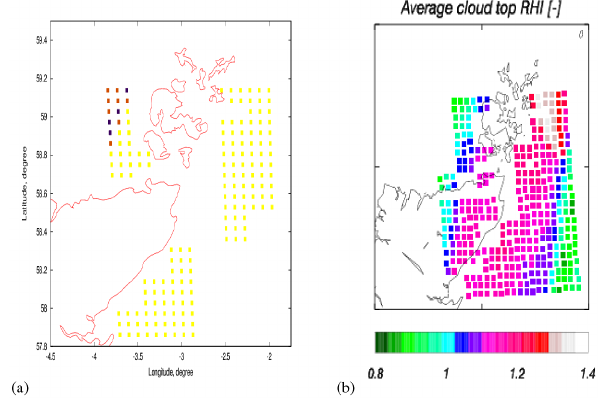
Figure 11. Associating the PARASOL estimations of shape of the scattering phase function at each pixel to the NWP-model-predicted field of RH i . (a) The estimated shape of the scattering phase func- tion; the yellow squares are as previously defined in Fig. 9. The brown squares represent those PARASOL pixels where no phase function model could be assigned, and the blue squares represent those pixels where phase function models assuming distortion val- ues of between 0 and 0.25 could be assigned. (b) The NWP-model- predicted cloud-top RH i field, where the colour bar indicates the range in predicted RH i